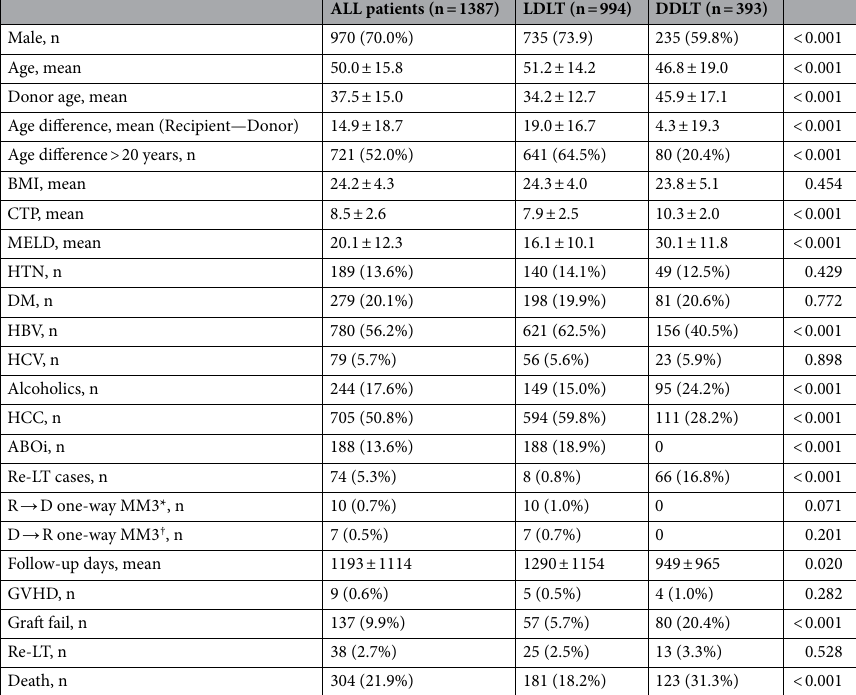
Table 1. Patient characteristics according to donor types. *Recipient against donor one-way mismatch in 3 loci. † Donor against recipient one-way mismatch in 3 loci.